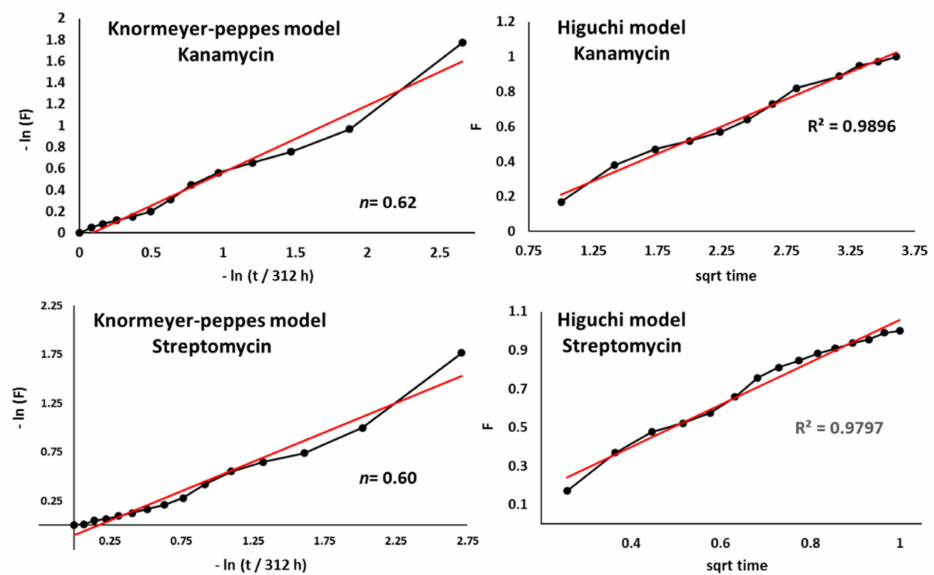
Figure 9. Drug release data fitted to Korsmeyer–Peppas and Higuchi models for kanamycin and streptomycin release (sqrt = square root of